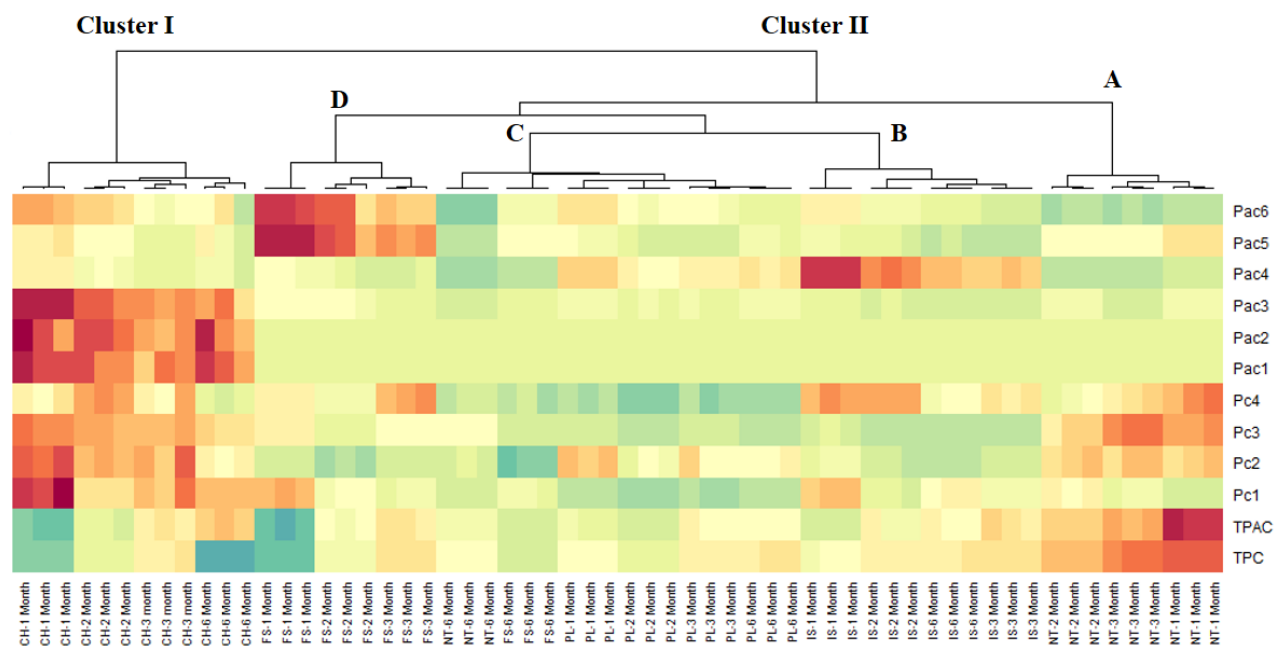
Figure 2. Cluster image map (CIM) analysis of the phytochemical composition data of comfrey roots (red color: high concentration, blue color: low concentration). Pac1, intermedine; Pac2, lycopsamine; Pac3, acetylintermedine/acetyllycopsamine; Pac4, intermedine- N -oxide; Pac5, lycopsamine- N -oxide; Pac6, acetylintermedine- N -oxide/acetyllycopsamine- N -oxide Pc1, rosmarinic acid; Pc2, globoidnan A; Pc3, globoidnan B; Pc4, rabdosiin; TPAC, total phenolic acid content; TPC, total phenolic content.